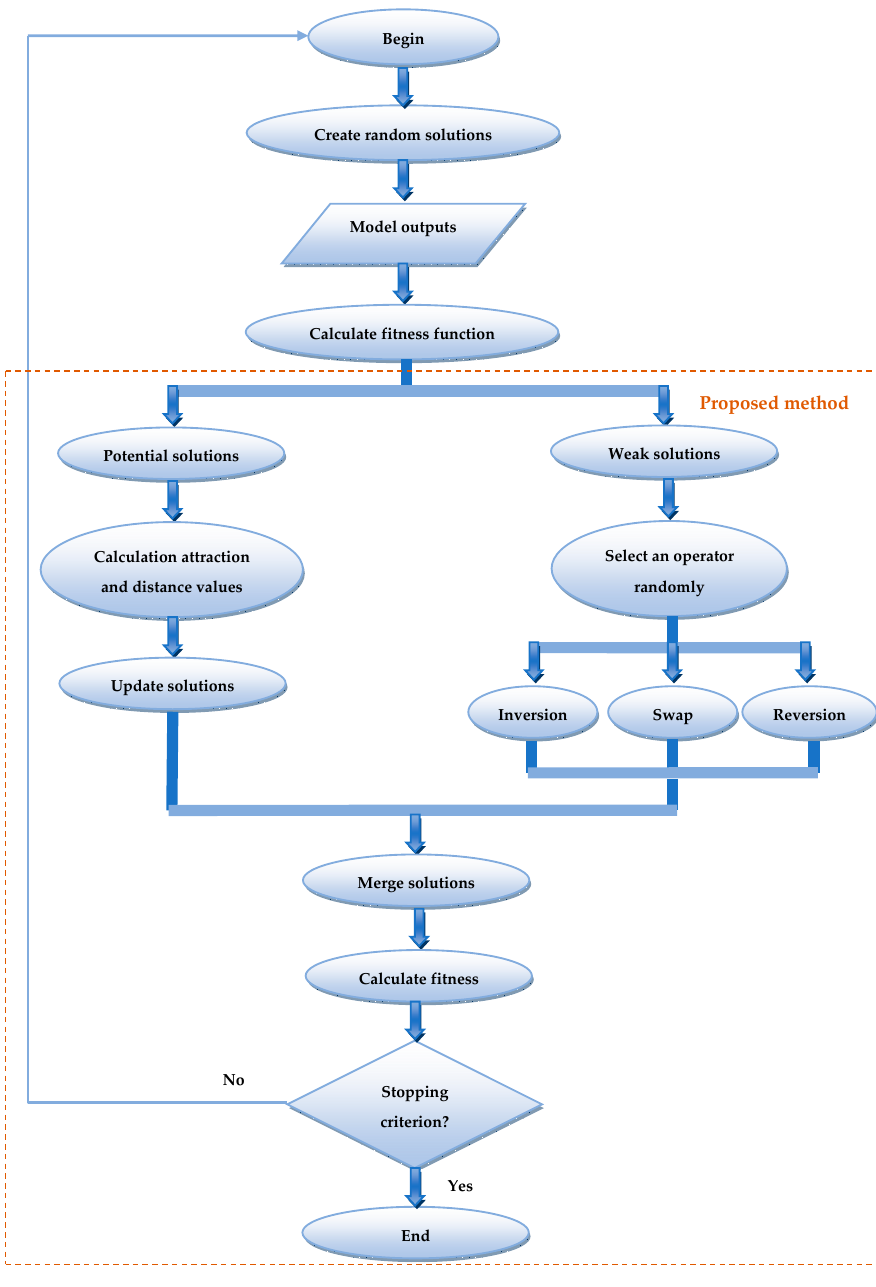
Figure 1. Graphical representation of modified FA. Figure 2. Graphical representation of modified